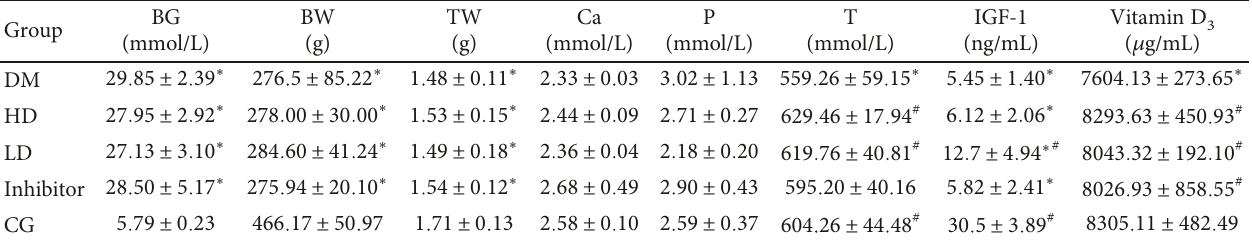
Table 2: Blood glucose (BG), body weight (BW), testicular weight (TW), and serum biochemical analysis at week 12.